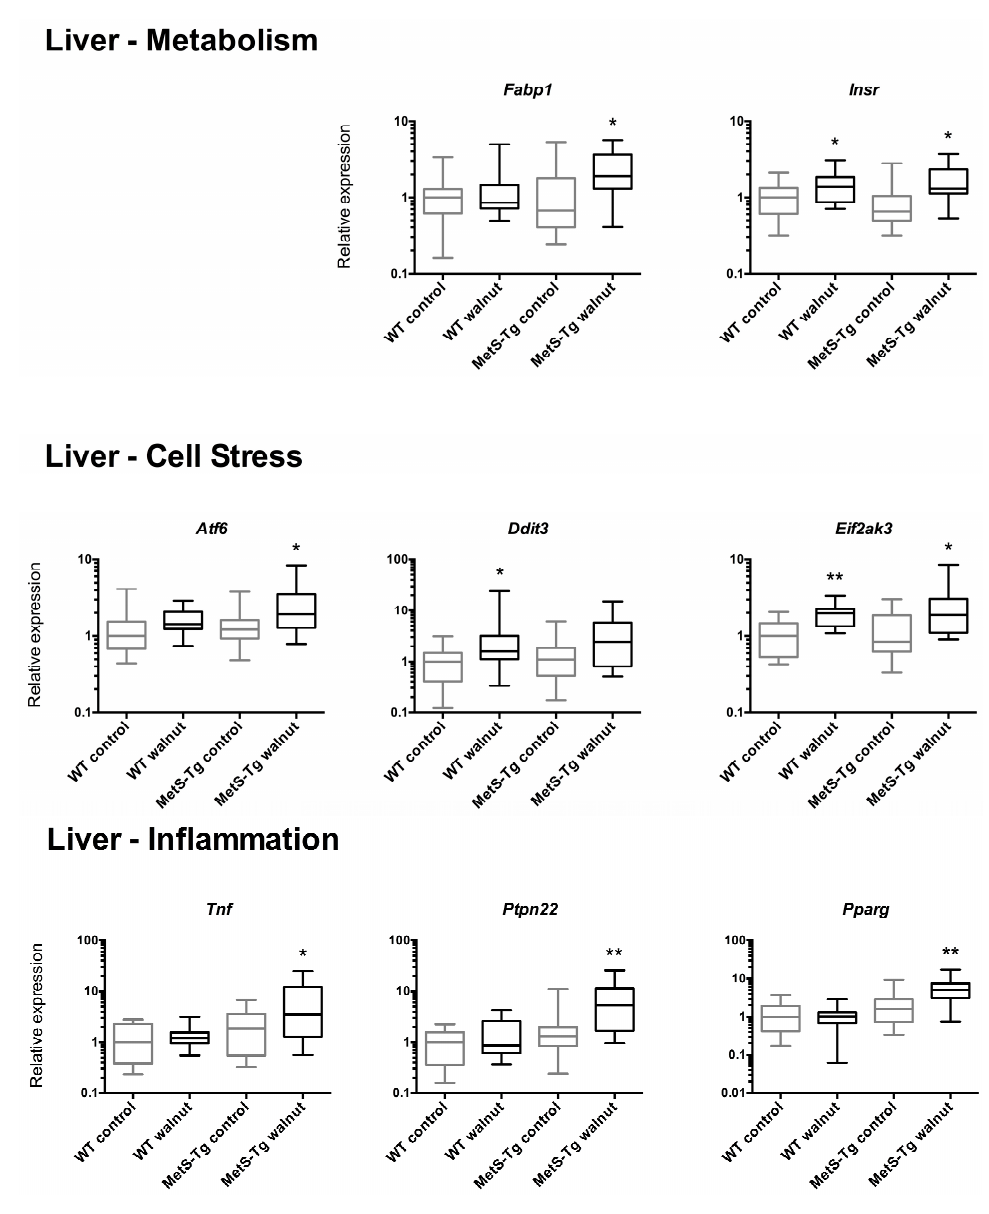
Figure 3. Relative levels of gene expression in liver for genes associated with metabolism ( Fabp1 , Insr , upper panel), cell stress ( Atf6 , Ddit3 , Eif2ak3 , central panel) and inflammation ( Tnf , Ptpn22 , Pparg , lowest panel), shown as medians (Interquartile Ranges) with WT control expression set to 1, * p < 0.05, ** p < 0.005.